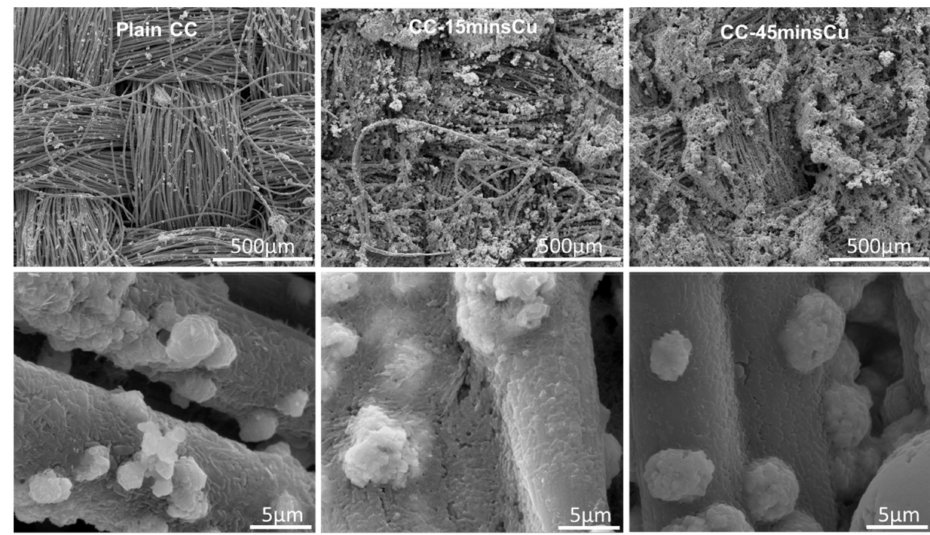
Figure 6. SEM images of low ( top row ) and high ( bottom row ) magnification of used plain CC ( left ), CC-15minCu (mid) and CC-45minCu ( right ) electrodes.